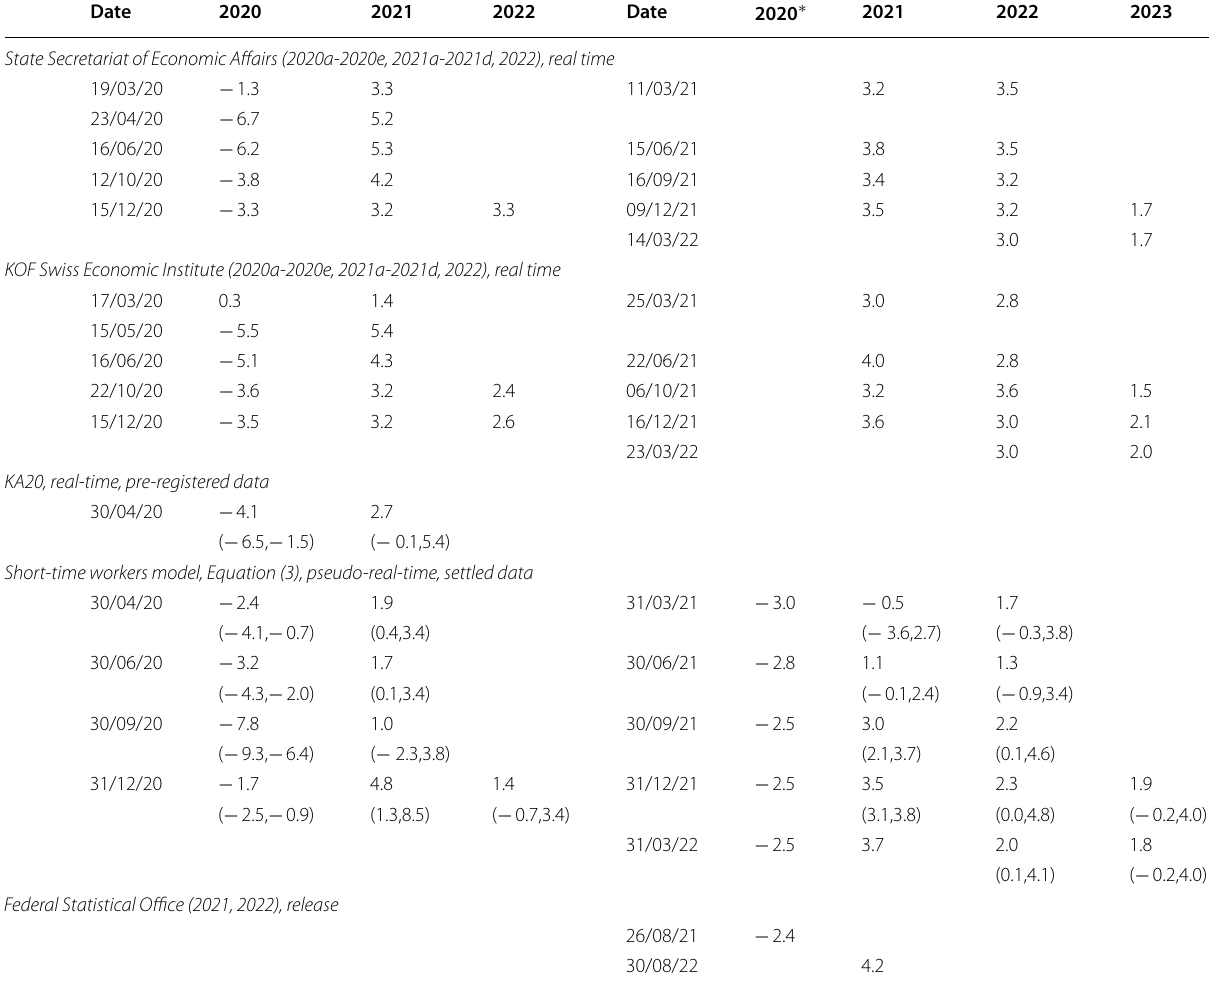
*Growth rates recorded in data